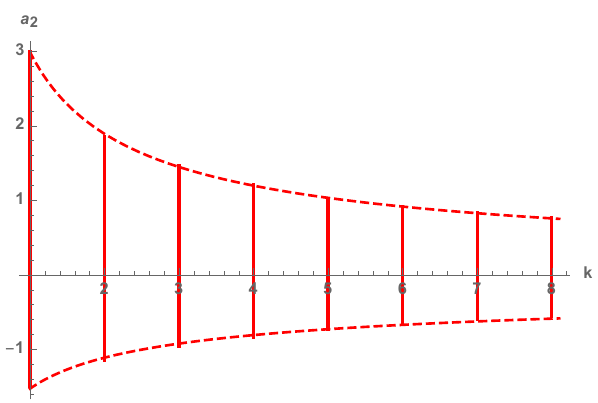
Figure 6 . A plot of the allowed parameter space for the coupling a 2 , as demanded by the positivity of the k -point function of ANEC operators. For k = 1, we have the conformal collider bounds. As we increase the number of operators, the region gets more and more constrained and is slowly closing in on a 2 = 0. We can (cid:12)t the bounds by a power law and we (cid:12)nd (cid:14) max (cid:24) 2 : 98 k (cid:0) 0 : 66 and (cid:14) min (cid:24) (cid:0) 1 : 53 k (cid:0) 0 : 46